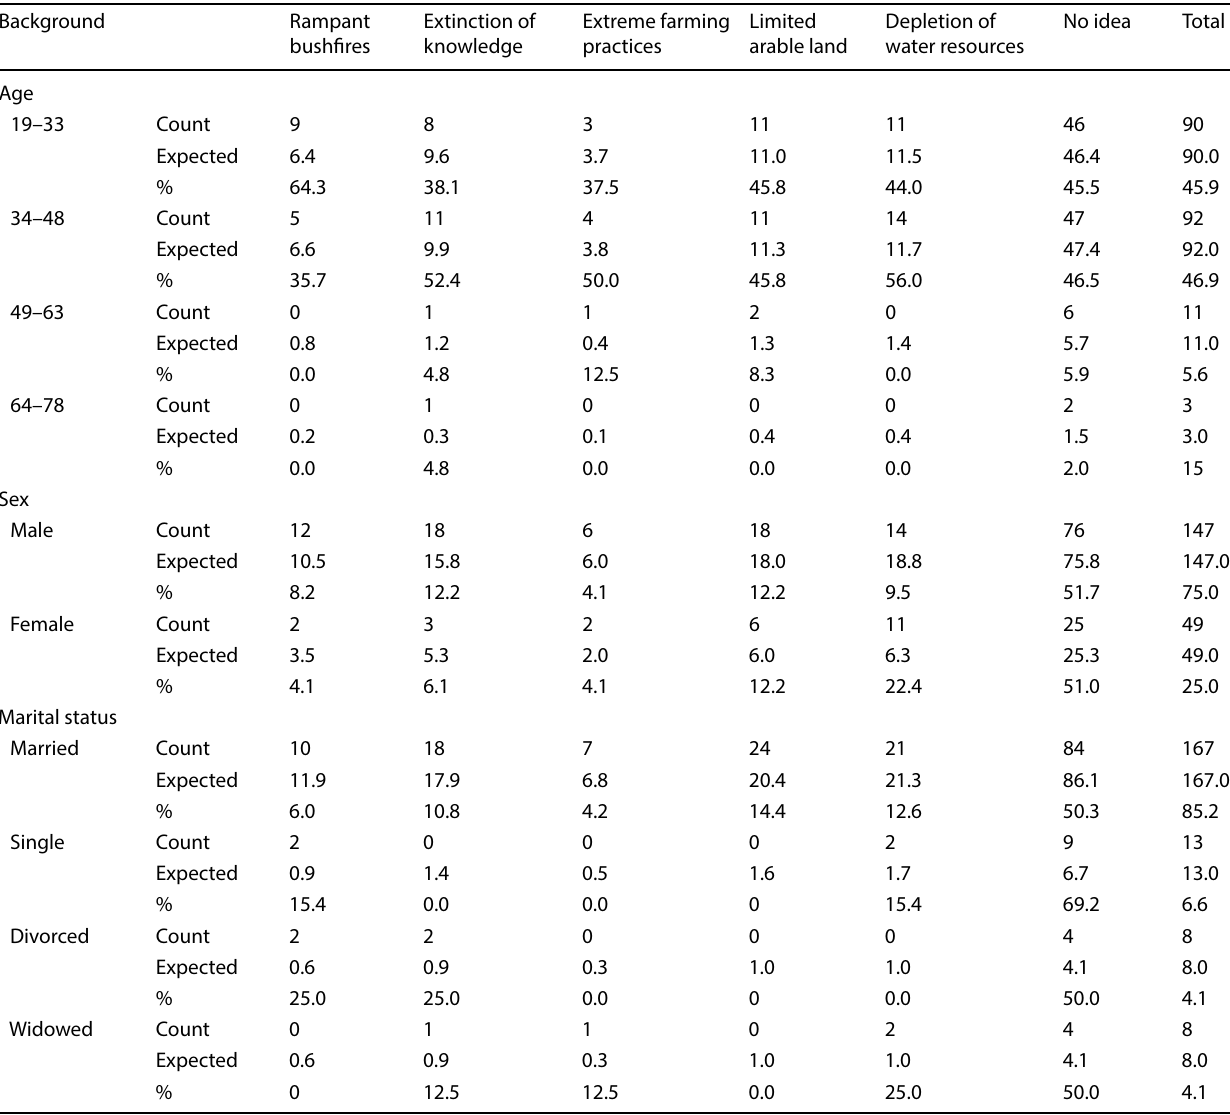
Table 4 Complexities with the application of local